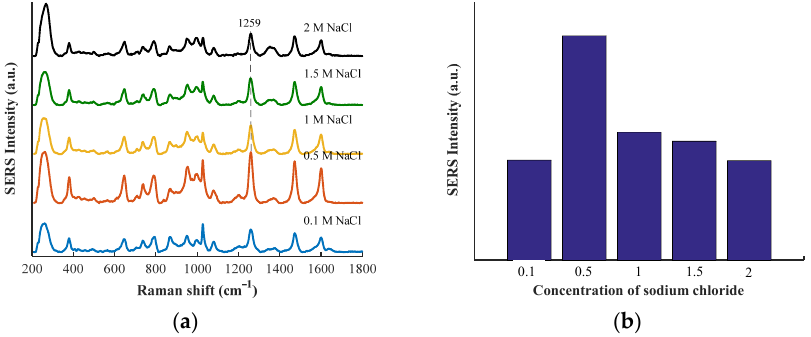
Figure 5. ( a ) SERS spectra of clenbuterol in pork using NaCl solutions at different concentrations as aggregating compounds; ( b ) SERS intensity of clenbuterol in pork at 1259 cm − 1 using different con-centrations of NaCl solution as aggregating